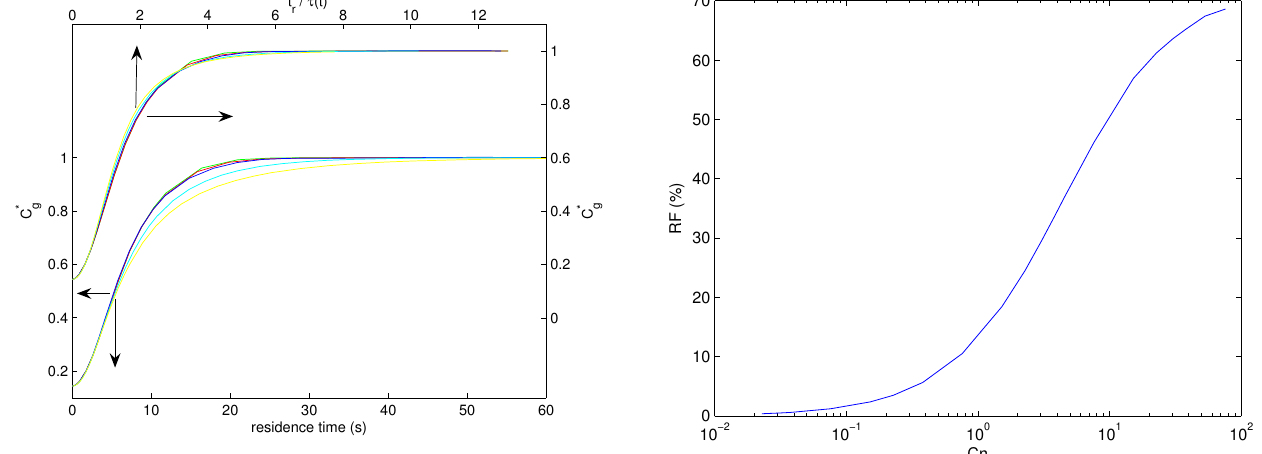
Fig. 6. Simulated normalized vapor build-up profiles in a TD as a function of residence time (bottom x-axis and left y-axis) and time-dependent equilibration parameter (upper x-axis and right y-axis).